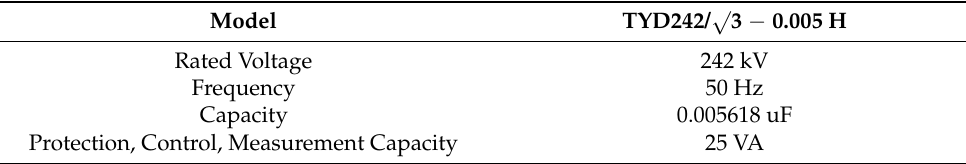
Table 1. Nameplate parameters of CVT.